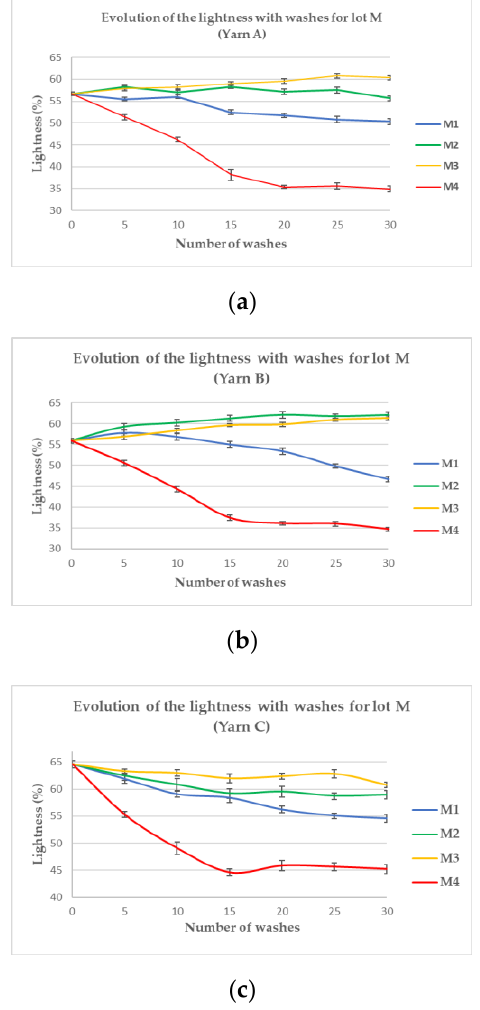
Figure 7. Evolution of the lightness with washes from Lot M, Yarns A ( a ), B ( b ) and C ( c ).